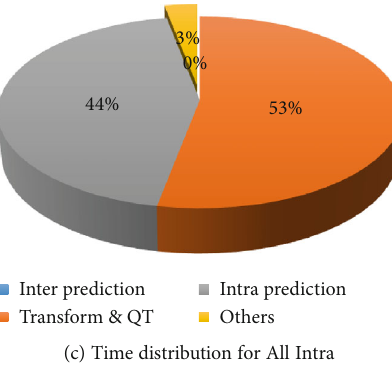
Figure 10: Encoding time distribution for (a) Random Access, (b) Low-Delay P, and (c) All